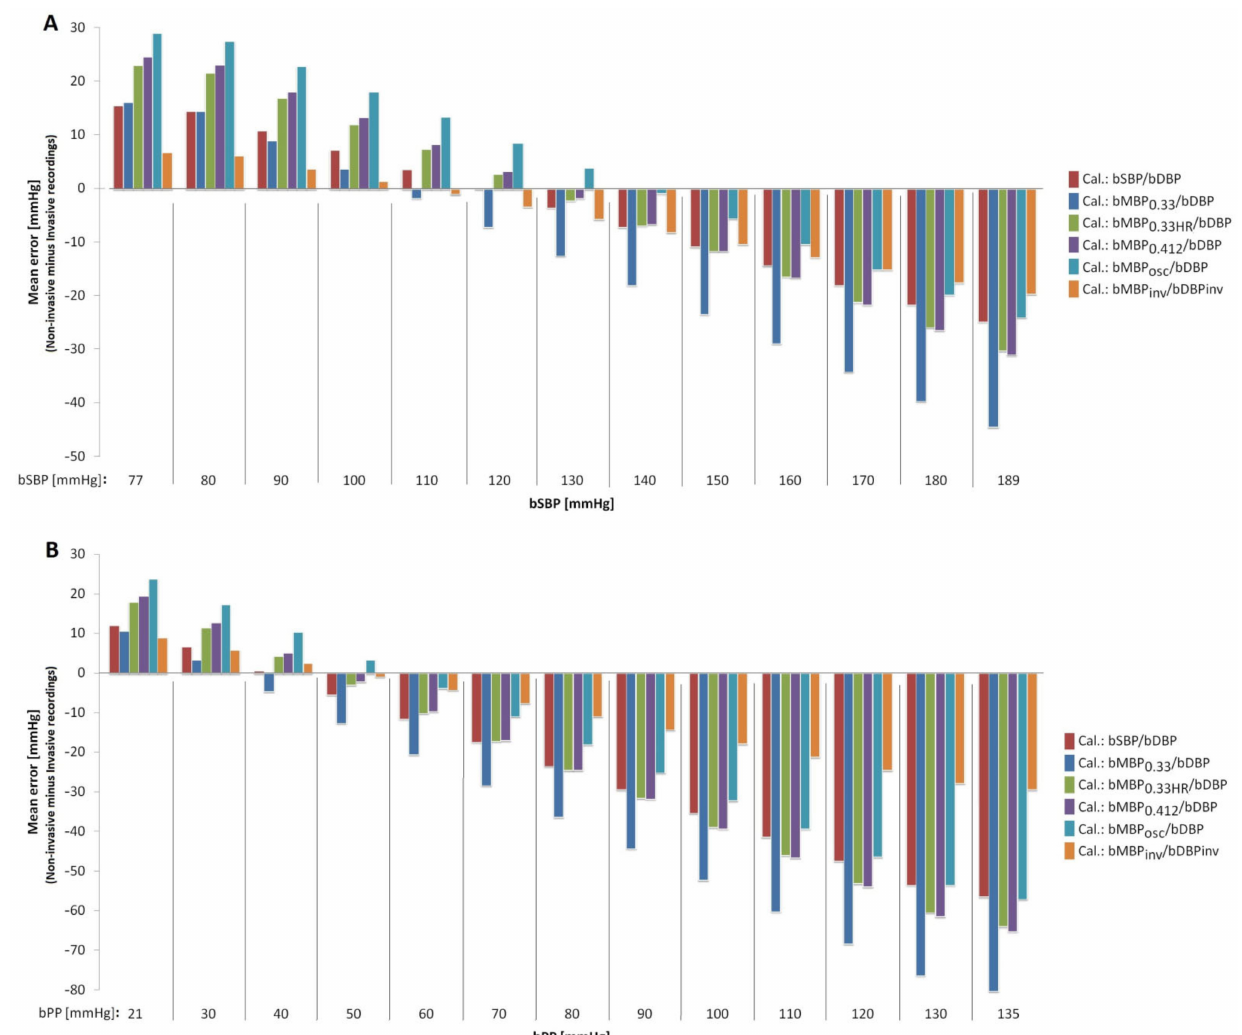
Figure 3. ( A ): Errors between non-invasive brachial systolic blood pressure (bSBP) obtained using different calibration schemes and invasive bSBP data (for different pressure levels). ( B) : Errors between non-invasive pulse pressure (bPP) obtained with different calibration schemes and invasive bPP measurements (for different BP